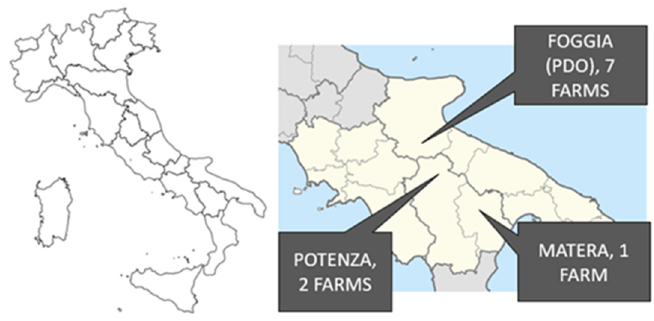
Figure 2. Farms Figure 2. Farms location.